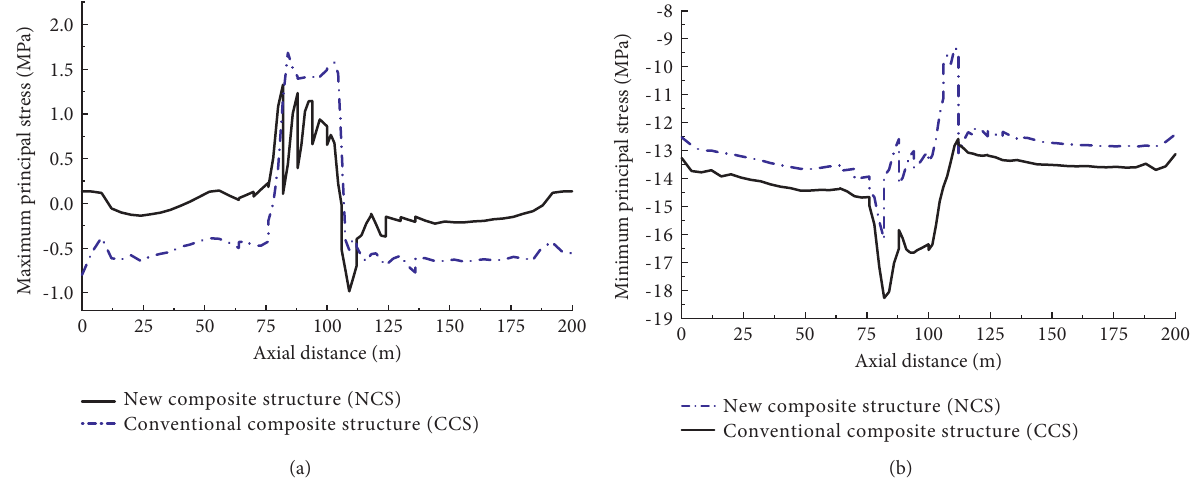
Figure 9: Distribution curve of the principal stress of the lining arch springing along the axial of the tunnel. (a) Maximum principal stress. (b) Minimum principal